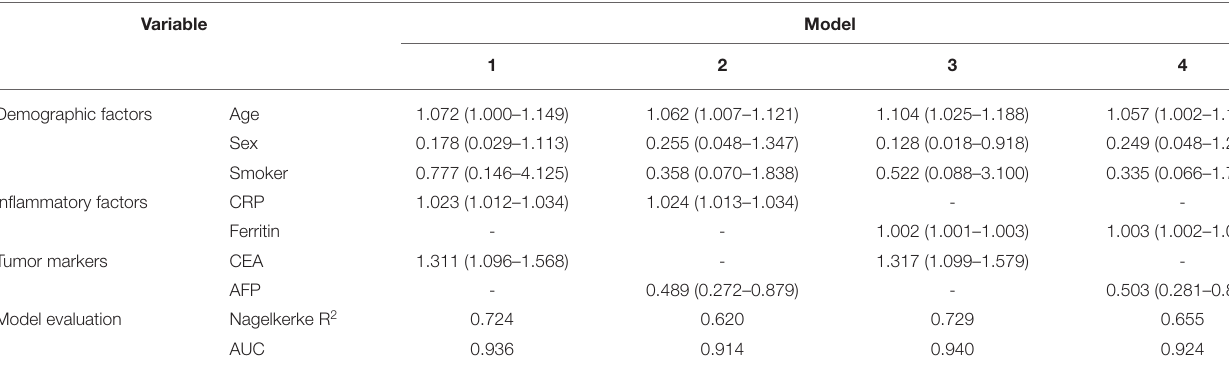
TABLE 2 | Binary logistic regression analysis of factors related to covid-19 prognosis.